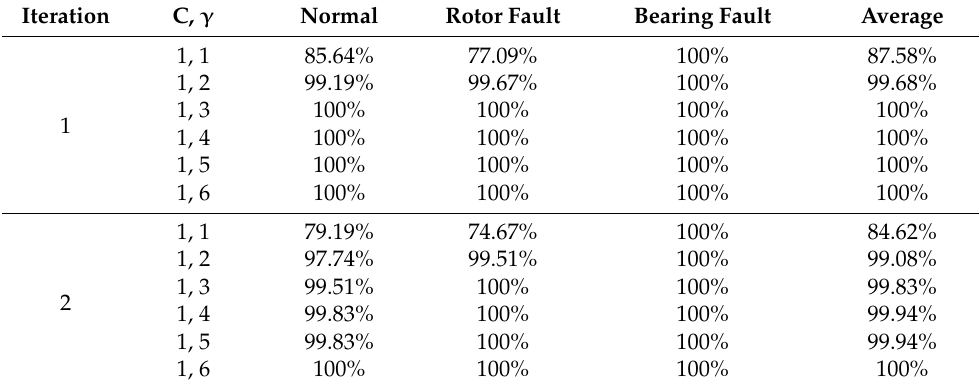
Table 2. Diagnostic accuracy of support vector machine for